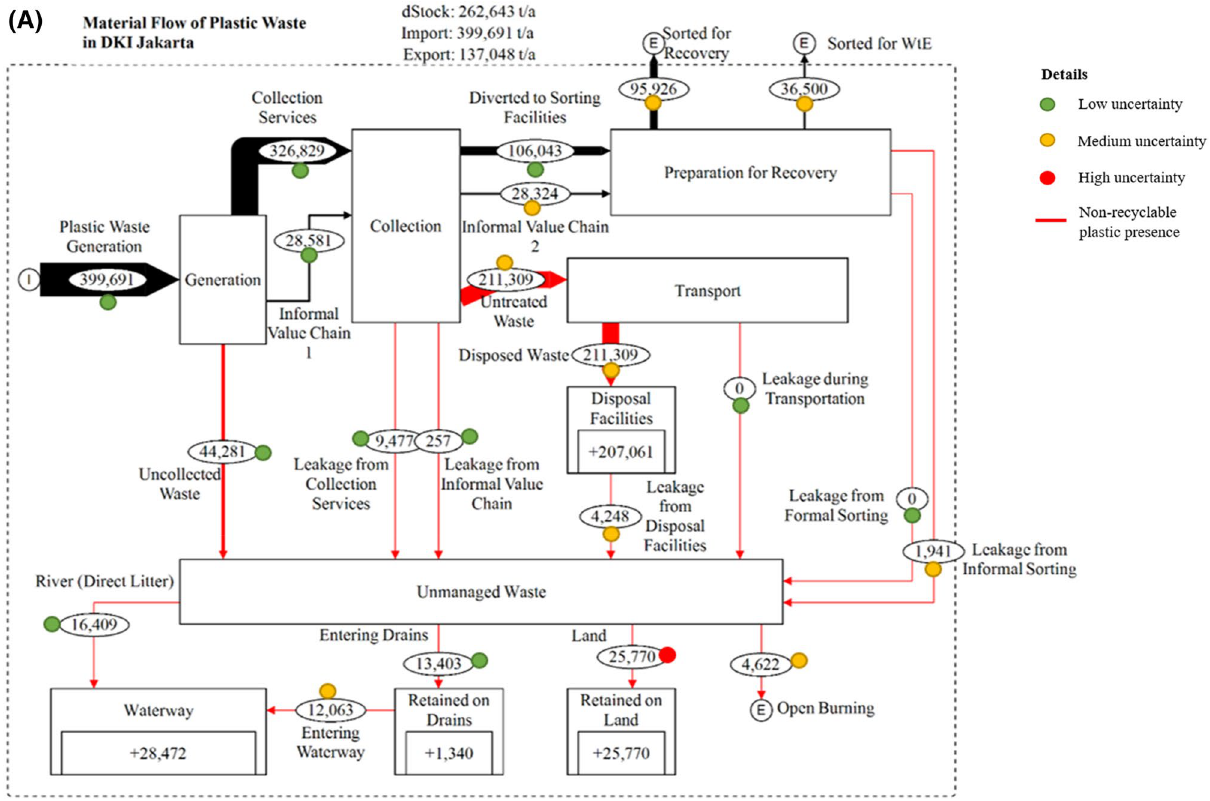
Figure 1. Material flow analysis in (top) DKI Jakarta and (bottom) Bandung City identifying the flow of plastic material from the generation to the different fate based on the